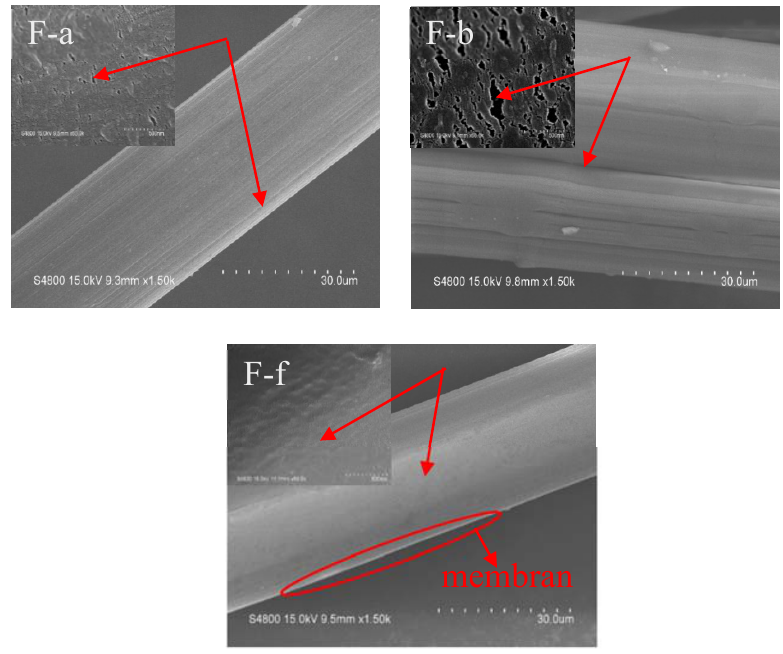
Figure 7. Surface morphology of the fiber treated by method F ‐ a, F ‐ b and F ‐ f at 0.10 g/mL PVA.